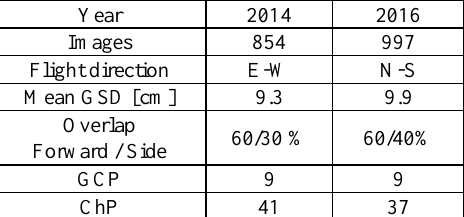
Table 1. Oblique images block parameters